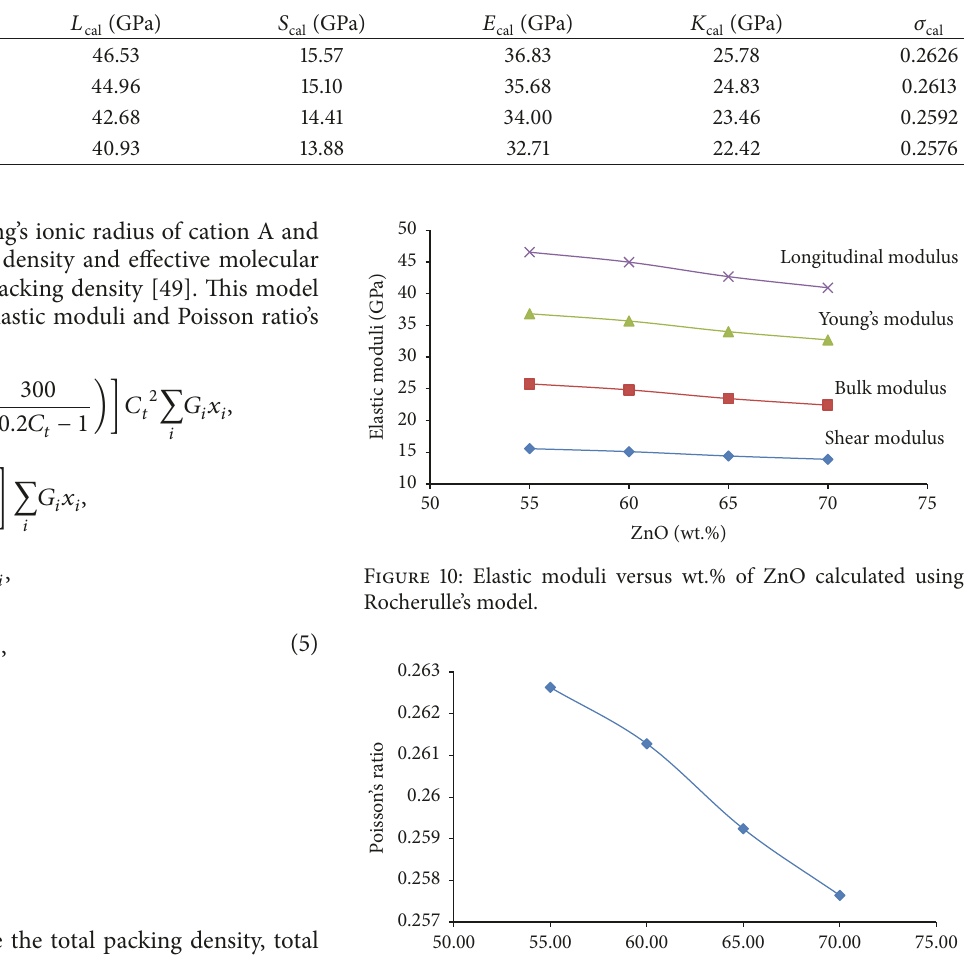
Table 5: Theoretical calculated total packing density, elastic moduli, and Poisson’s ratio of ZnO–SiO 2 samples. Theoretical elastic moduli and Poisson’s ratio Sample